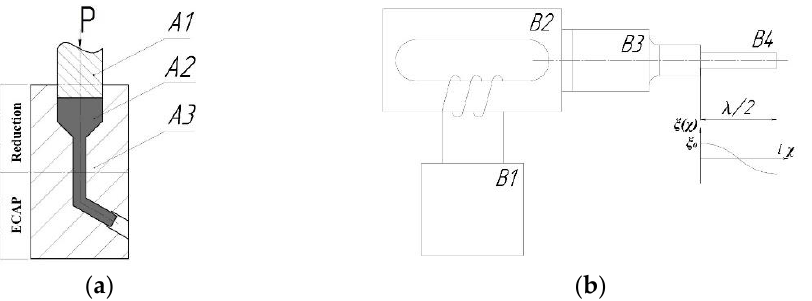
Figure 1. Layout of deformation processing ( a ): A1 — plunger; A2 — specimen; A3 — die. Layout of ultrasound post-deformation processing ( b ): B1 — ultrasonic generator, B2 — ultrasonic transducer, B3 — waveguide, B4 — half-wave length sample.